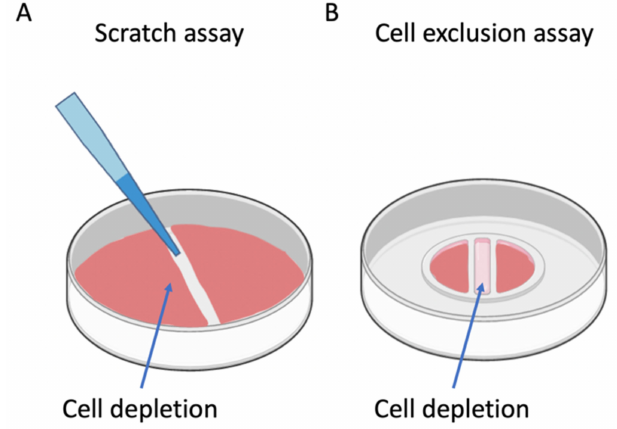
Figure 2. In vitro wound healing assays. ( A ) Scratch assays most frequently use pipette tips to manually scratch and remove cells from a cell monolayer. ( B ) Cell exclusion assays block a wound area before cell adhesion with a physical barrier insert removed after the establishment of the cell layer integrity to create a well-defined